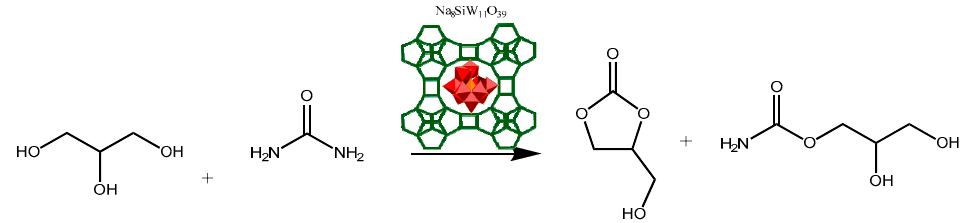
Figure 36. Effect of the Keggin anion on the conversion and selectivity of glycerol carbonatation with urea over Sn/Cs supported solid catalysts (adapted from ref. [75]).